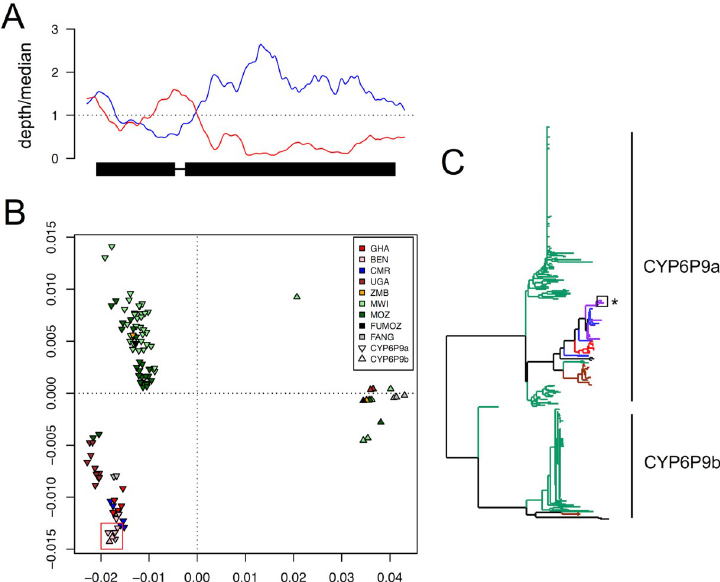
Fig 5. Gene conversion between CYP6P9a and b in Benin. (A) Coverage depth (relative to the genomic median) across CYP6P9a (blue line) and CYP6P9b (red line) in the Benin population, suggesting that a large proportion of reads from ‘ CYP6P9b ’ align to CYP6P9a . The gene is shown at the bottom (transcribed from right to left), thick black regions indicating exons and the thin black line the intron. (B) Multidimensional scaling (MDS) plot based on pairwise sequence divergence (uncorrected) among 400 CYP6P9 sequences (281 CYP6P9a ; 119 CYP6P9b ). The red box indicates the location of Benin CYP6P9b genes among CYP6P9a genes. The plot also shows the divergence in CYP6P9a between southern Africa (Zambia Malawi, Mozambique) and other parts of the continent (Ghana, Benin, Cameroon, Uganda). (C) Neighbour-Joining tree for 281 CYP6P9a and 119 CYP6P9b sequences. Branches are coloured by geographical region: southern Africa (Malawi, Mozambique, Zambia) in green; Uganda (brown); Ghana (red); Cameroon (blue); Benin (purple). All CYP6P9b are clustered together except for 4 sequences from Benin, whose positions among the CYP6P9a clade are indicated by a box and an asterisk. Within CYP6P9a there are two major clusters, one consisting predominantly of southern African sequences and the other consisting predominantly of sequences from elsewhere in